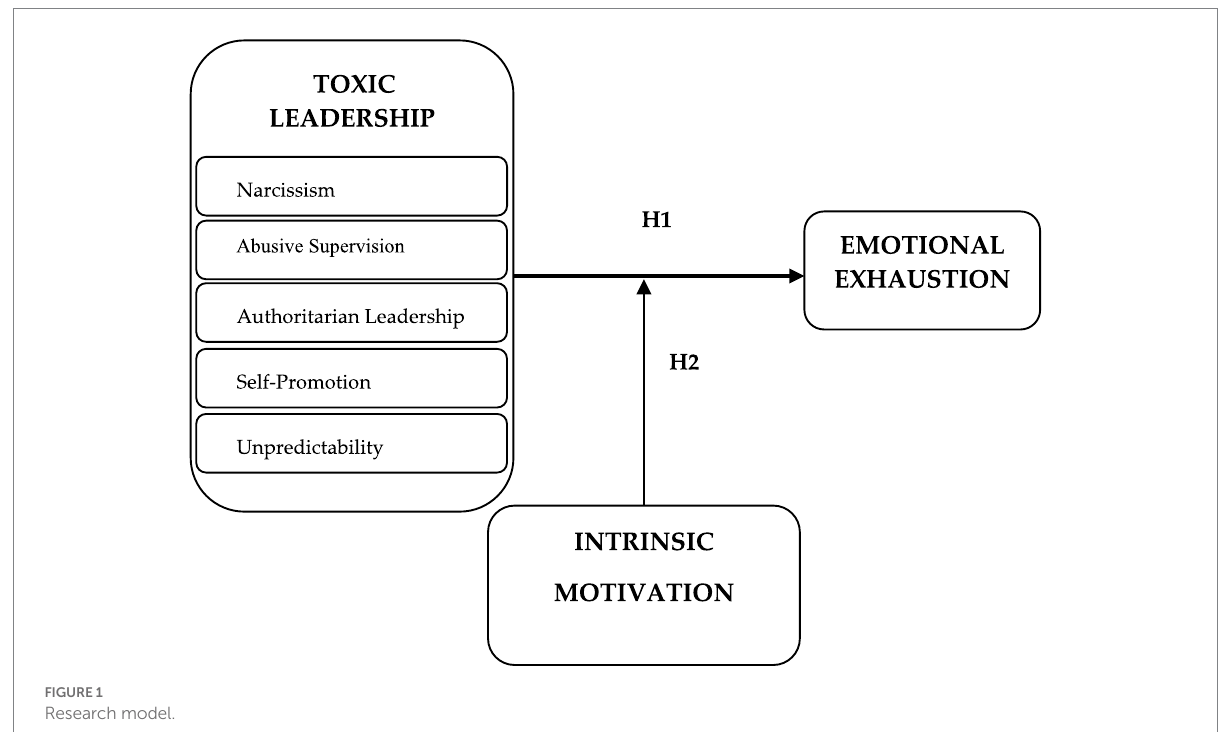
FIGURE 1 Research